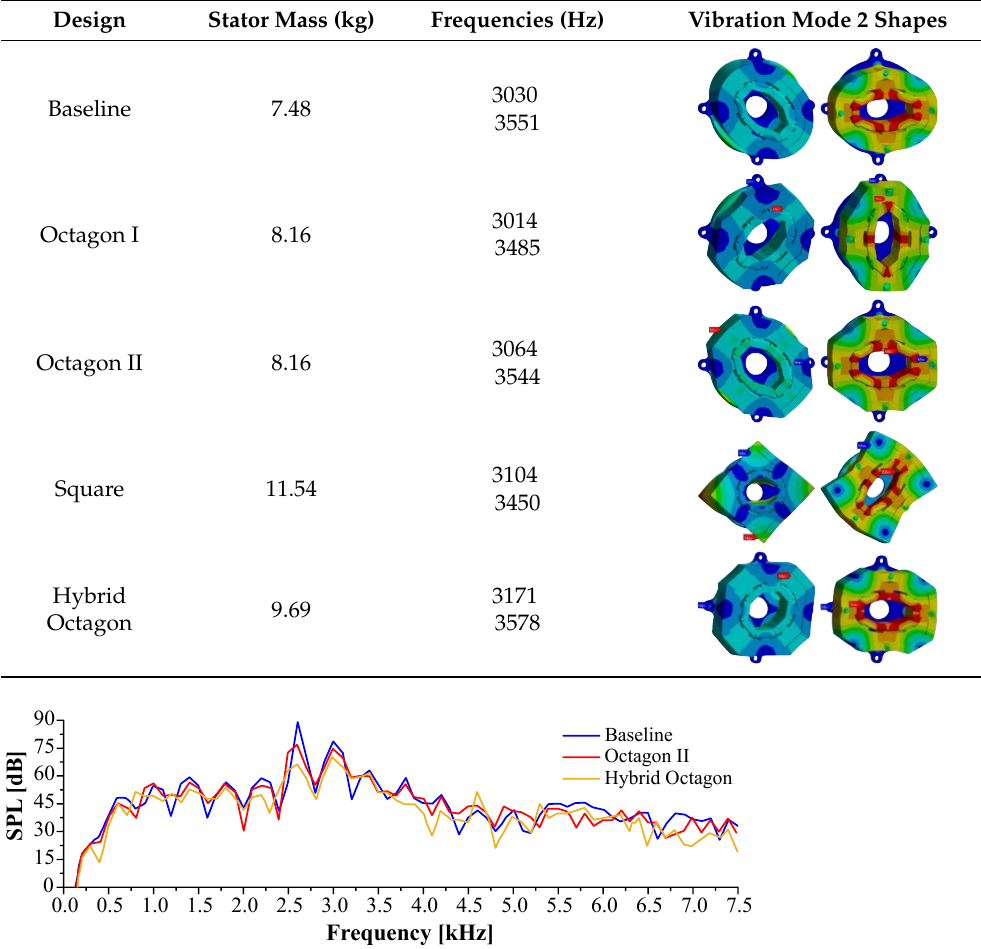
Figure 16. Total SPL comparison for Octagon II and Hybrid Octagon designs vs.